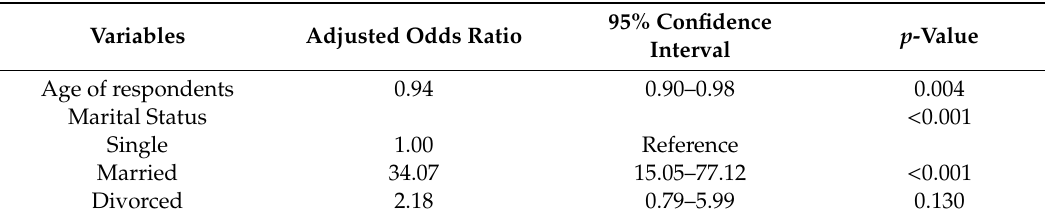
Table 3. Multiple logistic regression analysis of the variables associated with sexual activity among the patients on MMT ( n = 265).